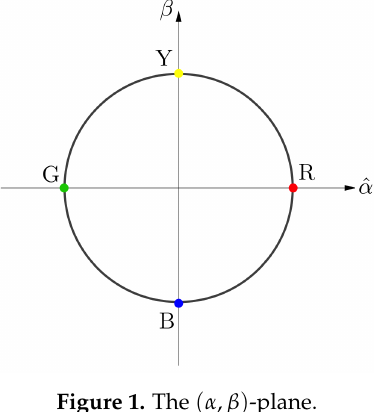
Figure 1. The ( α , β )